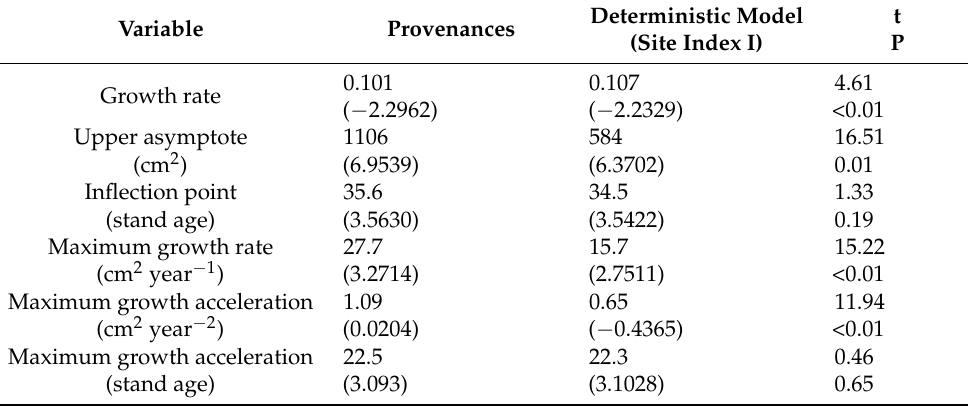
Table 3. Sigmoid growth model parameters and characteristic points of the first and second derivates for the provenance trial (mean for all plots, n = 86). The exact estimates for the deterministic model (the stand volume and yield tables, site index I) are provided. For the one-sample t -tests (df = 85), the values from the deterministic model were taken as a hypothesized mean. The comparison was made on log-transformed variables (provided in brackets) due to the tailed, not normally distributed values for the